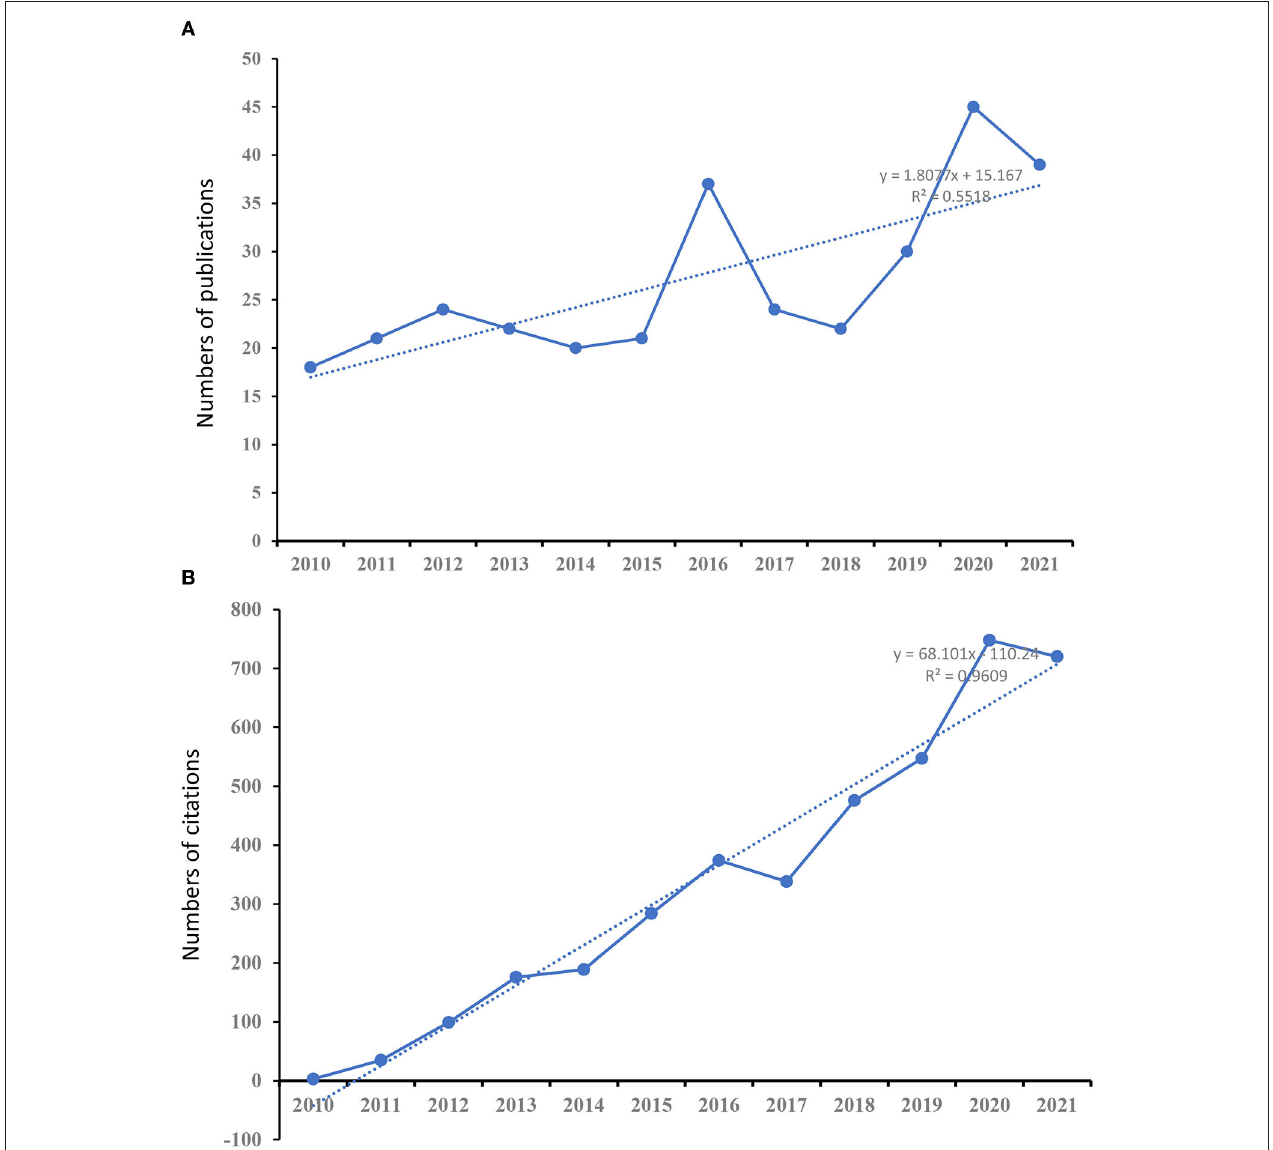
FIGURE 2 | The number of publications and citations. (A) The number of annual publications on studies of pain after stroke from 2010 to 2021. (B) The number of annual citations on studies of pain after stroke research from 2010 to 2021.